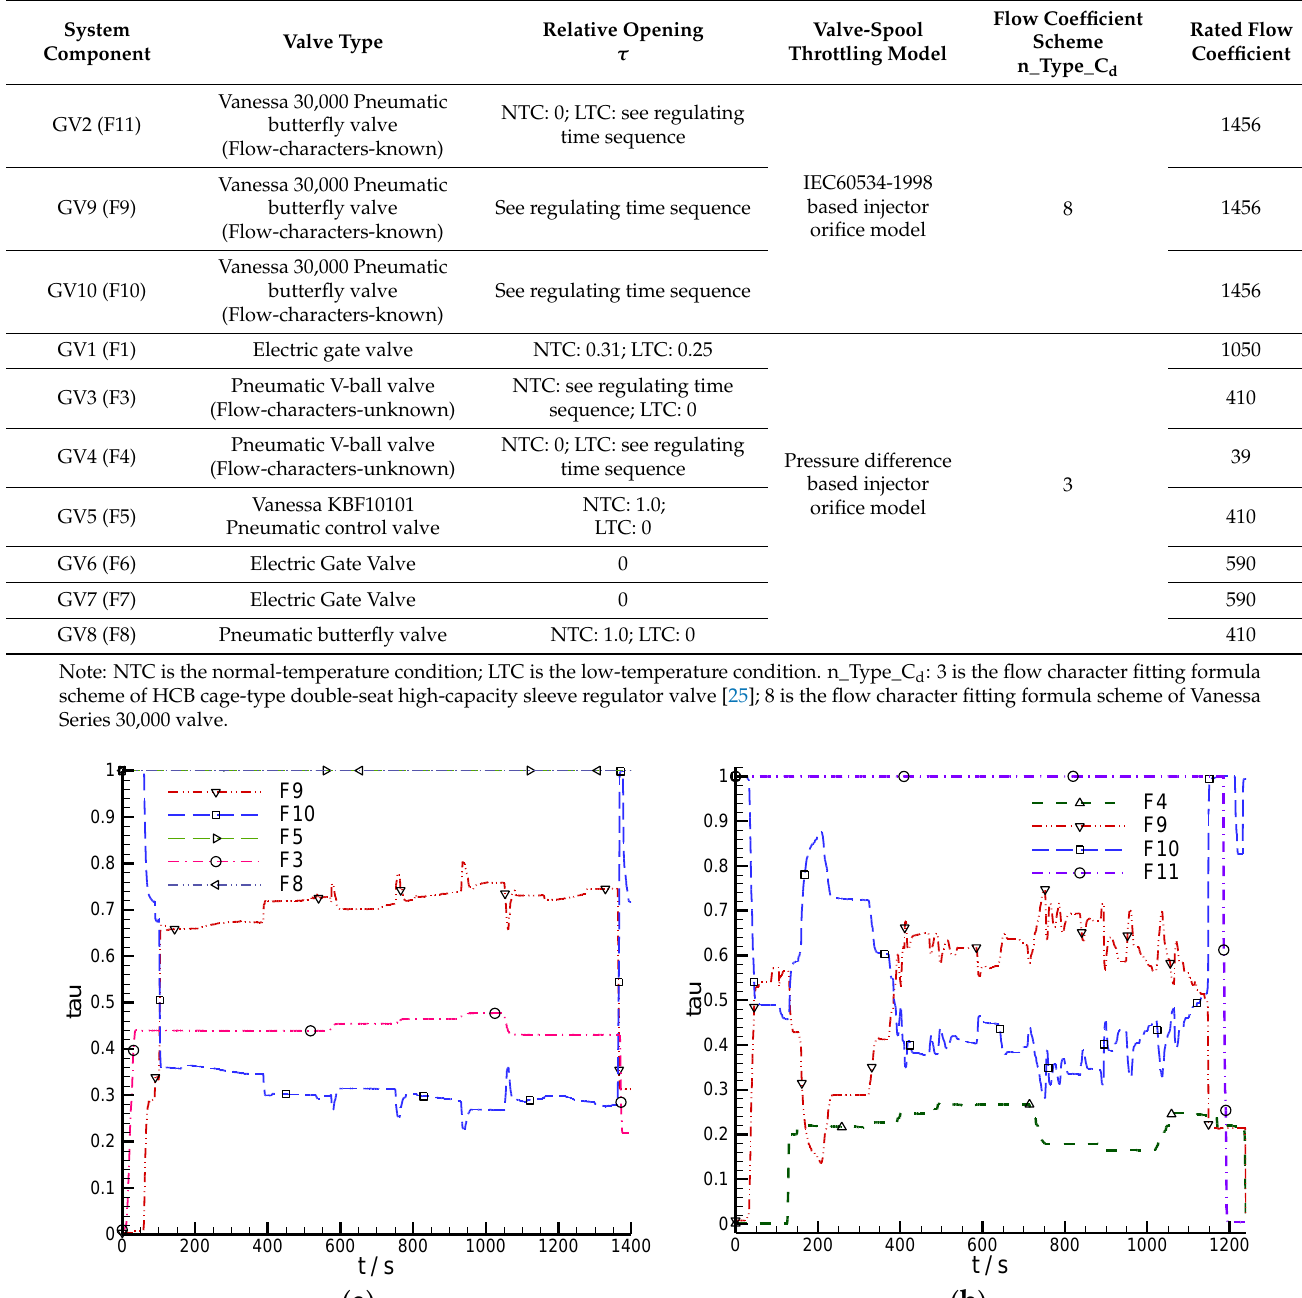
( b ) Figure 8. Boundary conditions of two operating conditions of the core engine test rig main test system. ( a ) Normal-tem- perature condition; ( b ) low-temperature condition. 5. Results and Discussion Figures 9a–f and 10a–f are the comparisons between the simulation results of normal- temperature and low-temperature operating conditions and the pressure, flow rate, total temperature, and total pressure curves actually measured by the main test system, of which the experimental flow rates are obtained indirectly by the total static pressure method with the total pressure and pressure measured by the sensors. The simulation data output frequency in the figures is 10 Hz. The subheading of each figure is named after the corresponding measurement point. See Figure 1 for the location of each measure- ment point, and the numerical simulation model of the system shown in Figure 6 for the location of each simulation data point. In the figures, the parameter curves not marked by symbol are test data, while the parameter curves marked by triangle, circle, and other symbols are the simulation results at the component grids corresponding to the locations of the sensor measurement points, in which the 0, n /2, and n − 1 along flow direction are